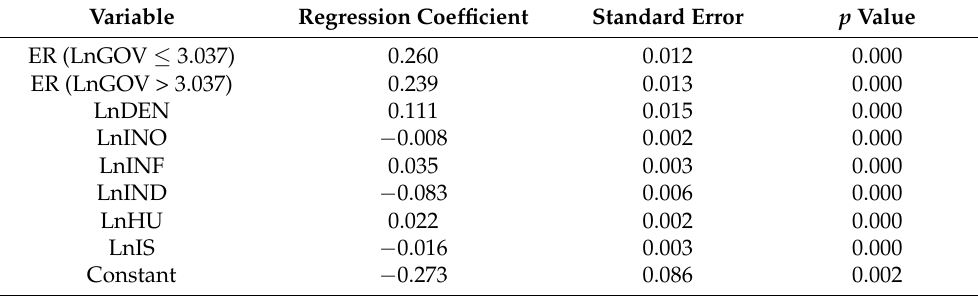
Table 5. Estimation results and tests of threshold regression mode.